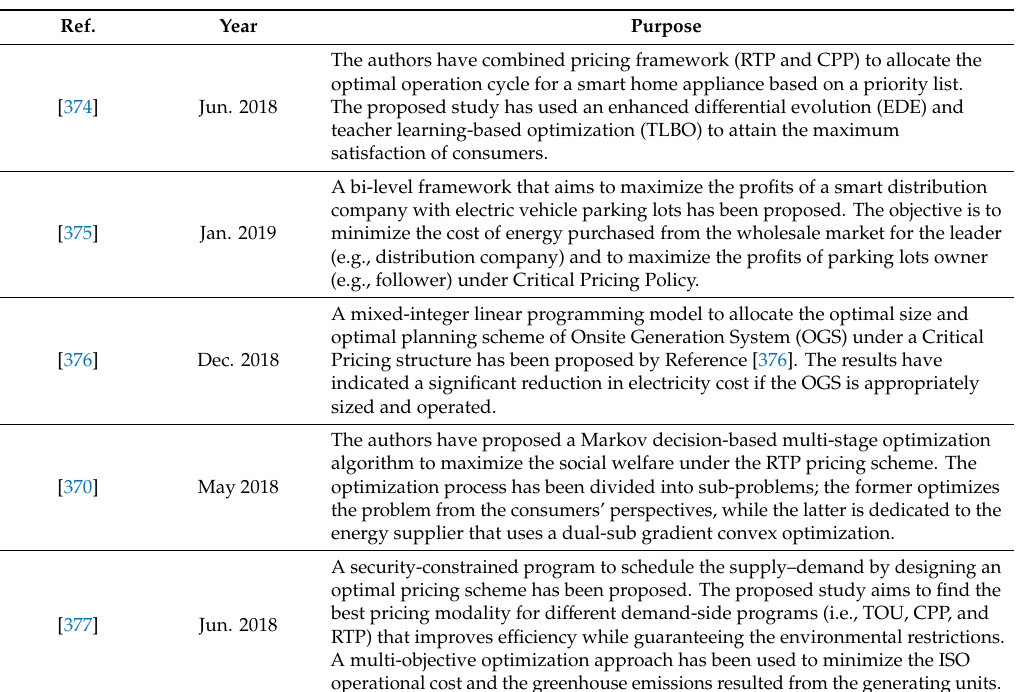
Table 13. Recent developments in critical peak pricing